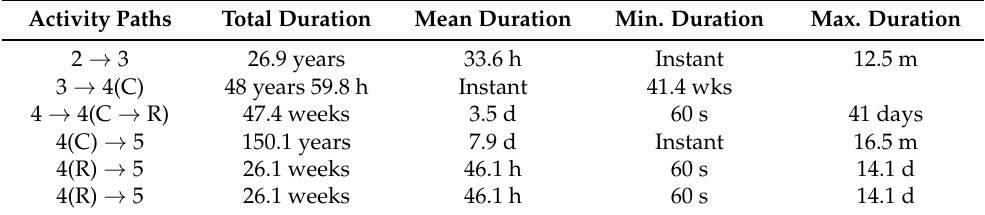
Table 12. Activity paths showing their time measures from a performance view. Activity